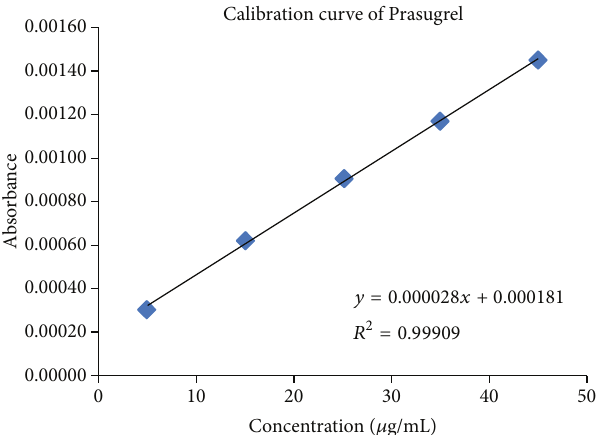
Figure 5: Calibration curve of Prasugrel (5–45 𝜇 g/mL) by second order derivative method.